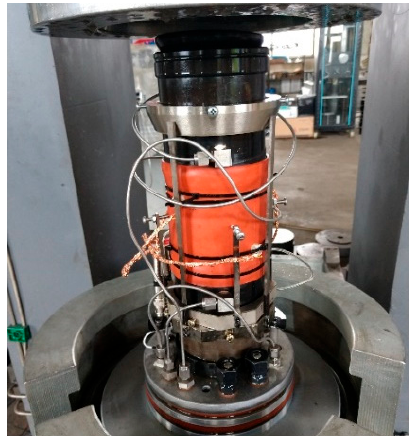
Figure 15. Specimen seal installed in the pressure chamber.